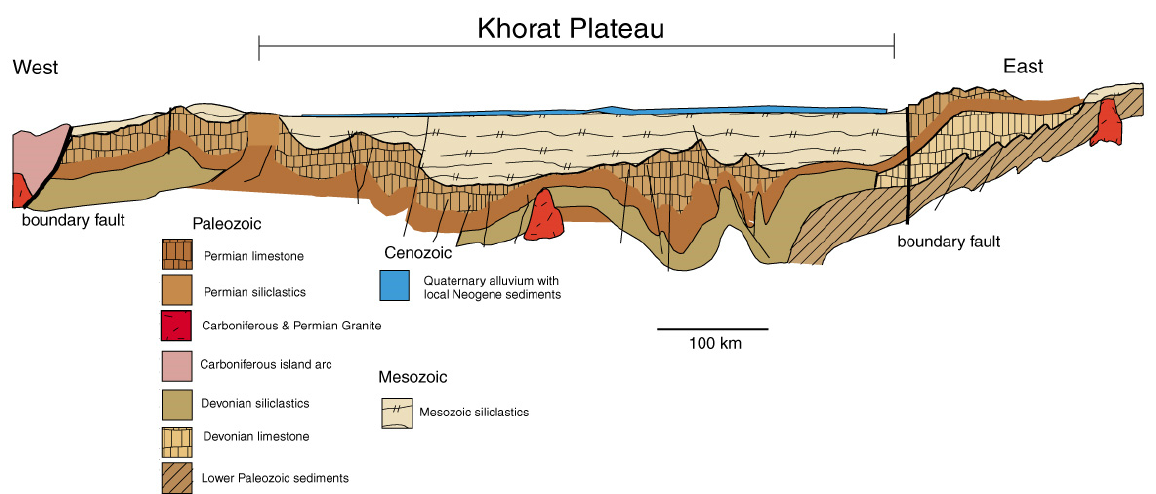
Figure 12. Generalized cross-section of the Khorat Plateau. Fossil wood occurs abundantly in Neogene alluvial fan deposits and Quaternary fluvial sediments that thinly cover large areas of the region.